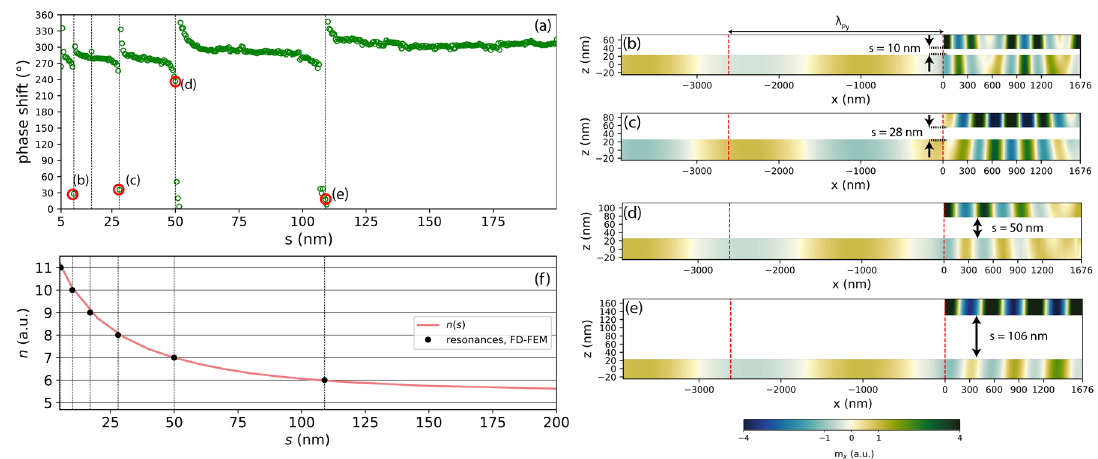
Figure 8. ( a ) Phase shift dependence on the separation between the FM2 stripe and Py film, calculated by the FD-FEM. ( b – e ) Snapshots of the dynamic magnetization m x at separations 10, 28, 50 and 106 nm, corresponding to the resonances marked in plot ( a ). The dashed red lines mark the SW wavelength in the Py film. ( f ) Red line: dependence of the resonance index n calculated from Eq. (4) on the separation s , with ϕ l + ϕ r set to the fitted value 0.12. Resonances are predicted to occur at integer values of n . Black circles: positions of resonances found in FD-FEM